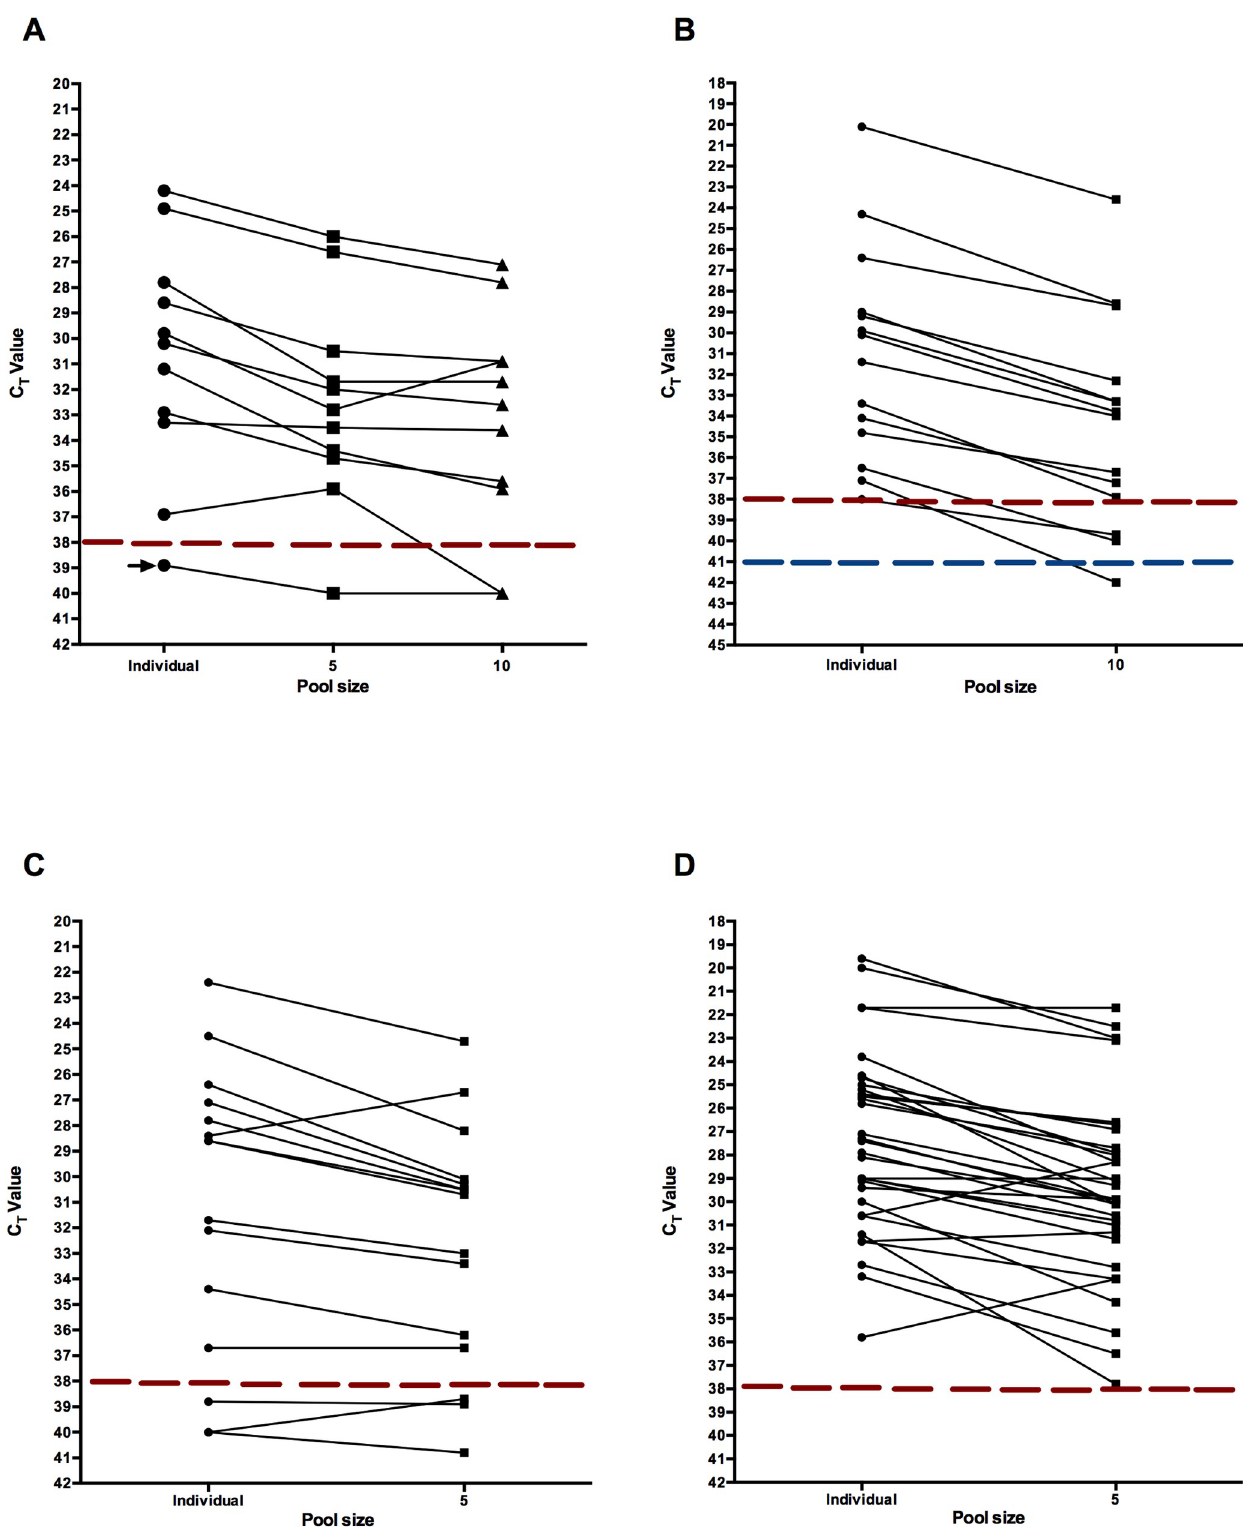
Fig 1. Detection of SARS-CoV-2 in pools of five and ten saliva samples. A) SARS-CoV-2 positive saliva samples were mixed with either four or nine negative samples. The C T value of the individual samples was compared to that obtained in the pooled samples; the mean change of C T was +1.7 (95% C.I: